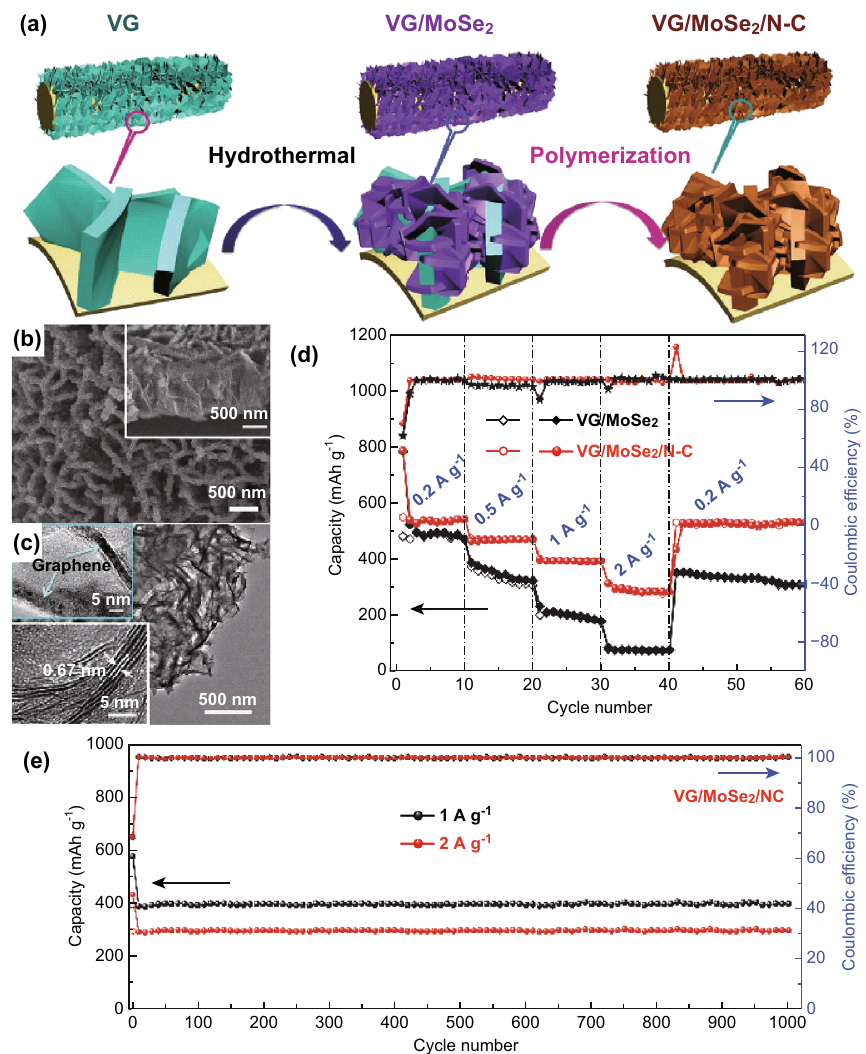
Fig. 12 3D architectures based on 2D MoSe 2 nanoflakes on 1D vertical graphene skeleton for SIBs. a Schematic illustration of synthesis of sandwiched VG/MoSe 2 /N–C core/shell arrays. b SEM and c TEM images of VG/MoSe 2 arrays. d Rate capability and e cycling stability of VG/ MoSe 2 /N–C electrodes at 1 and 2 A g - 1 , respectively. Reproduced with permission [132]. Copyright (cid:2) 2016, John Wiley & Sons,